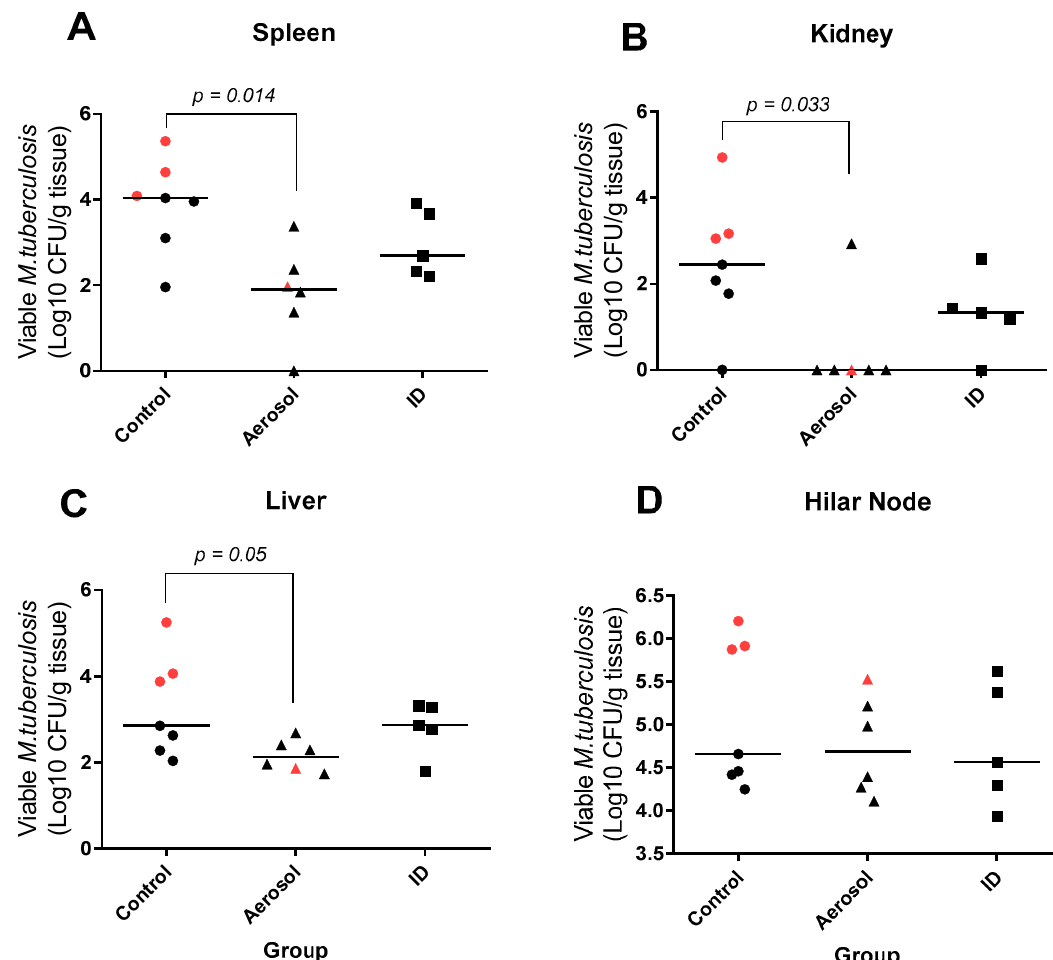
Figure 6. Viable M. tuberculosis recovered from Hilar lymph nodes and extra-thoracic tissues. Representative tissue samples collected from spleen ( A ), kidney ( B ), liver ( C ), and tracheobronchial lymph nodes ( D ) were homogenised and cultured on selective agarose for assessment of M. tuberculosis bacterial load in extrapulmonary and extra-thoracic tissues. Individual points represent log 10 CFU / g tissue recovered from each animal with the group median indicated by horizontal bar. Animals in which disease met humane end-point criteria are indicated with red data points. Significant differences between groups determined by Mann–Whitney U-test are shown.